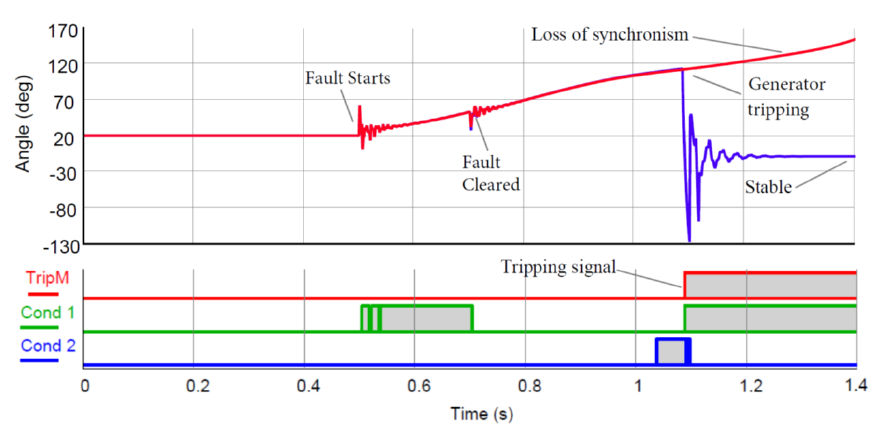
Figure 5. Unstable case against a 12-cycle fault: the angle difference between bus 1 and bus 5 when the machine A is not disconnected (red) and when the machine A is disconnected according the proposed tripping logic (blue), the evolution of the power condition is in green, the angle condition is in blue, and the tripping signal is in